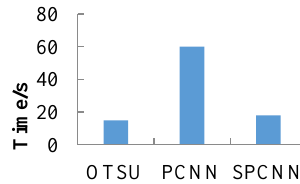
Figure 8. Time consumption of three segmentation